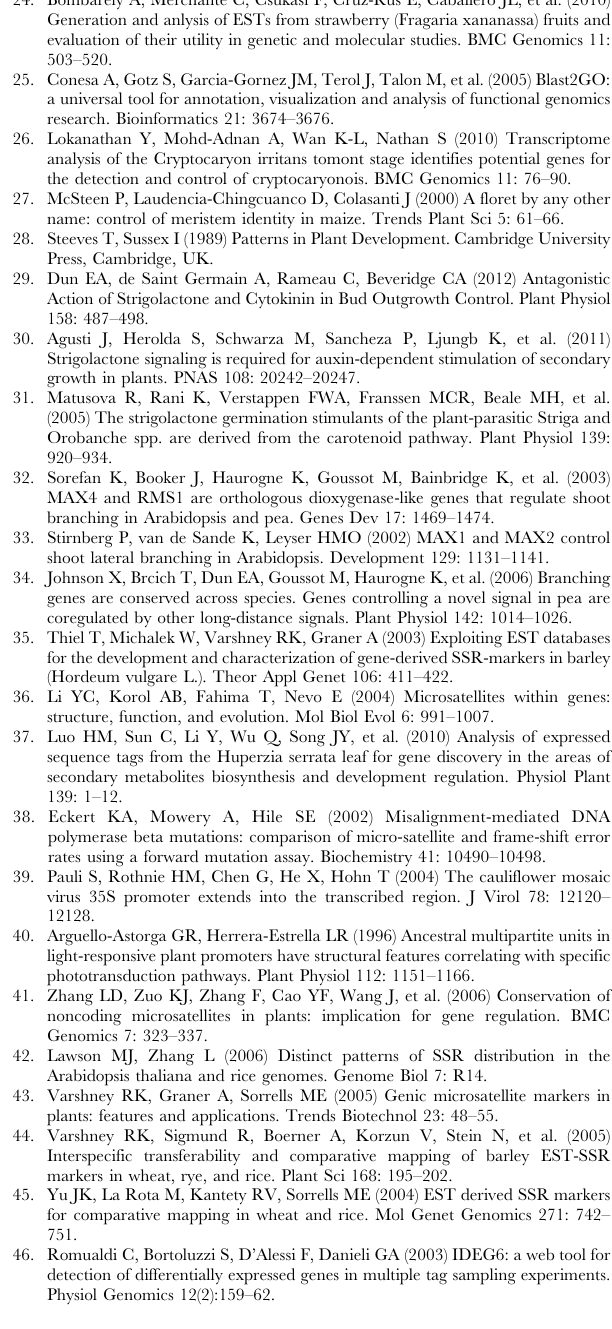
Table S1 49310 unigenes for Salvia splendens (FA). Table S2 The annotation by NCBI Nr, Nt, Swiss-Prot, KEGG, TrEMBL, COG and GO seqdb databases